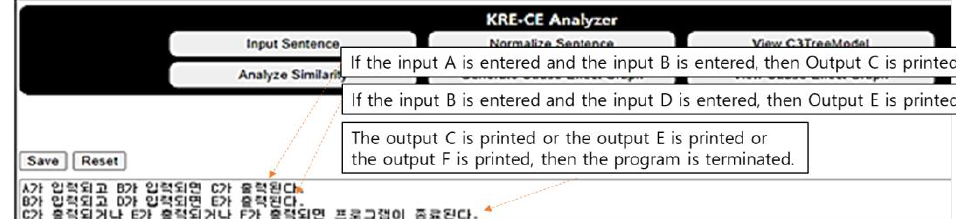
Figure 13. Input Korean requirements on UI menu.